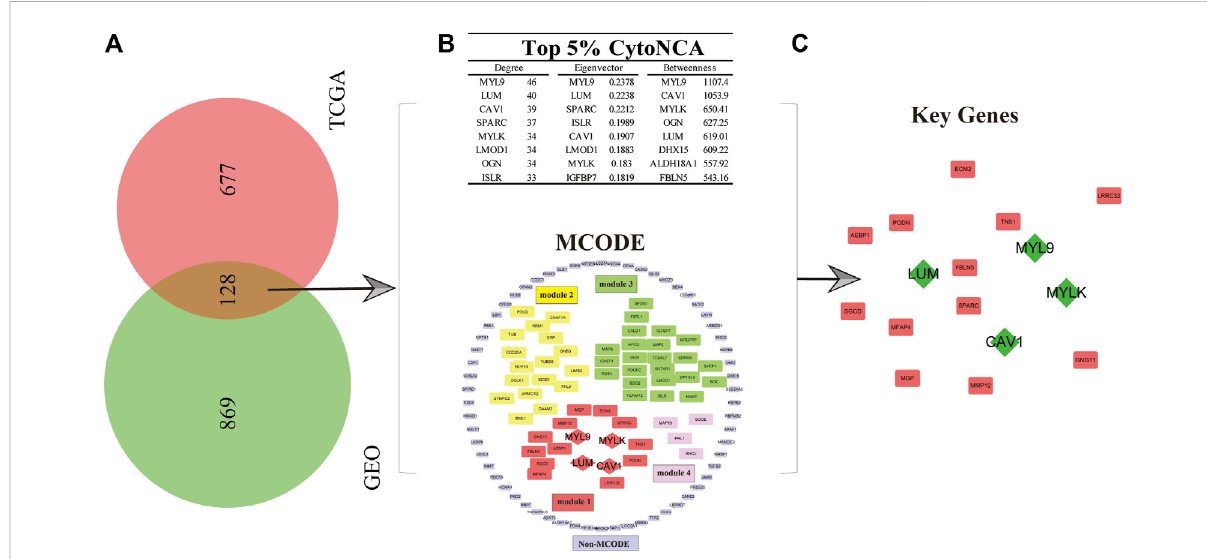
FIGURE 1 Selection of key genes for GC patients. (A) In total, 128 common P-DEGs were obtained from the intersection of TCGA and GEO datasets. (B) Four modules, namely, modules 1 – 4, and one non-MCODE module and a score ranked up in the top 5% in three parameters from CytoNCA ’ s centrality analysis. (C) Key genes ( MYLK , MYL9 , LUM , and CAV1 , green diamond in the picture) were